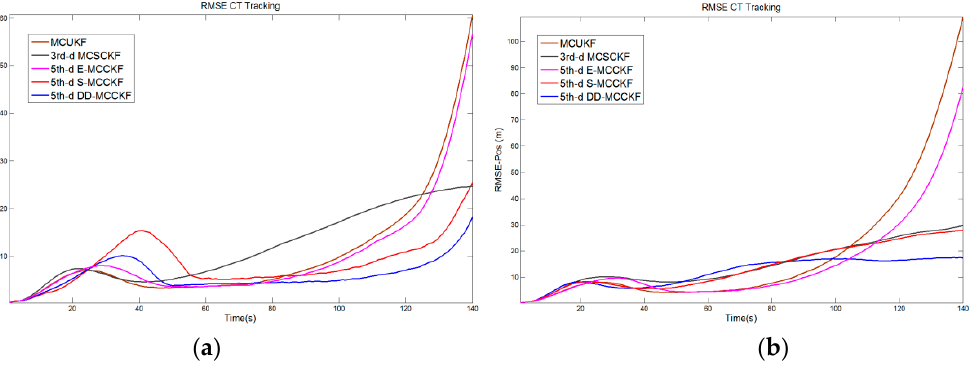
Figure 7. Tracking trajectories of a surface target (unmanned surface vessel) under non-Gaussian noise conditions (( a ) is the result under Equation (65) and ( b ) is the result under Equation (66)) .